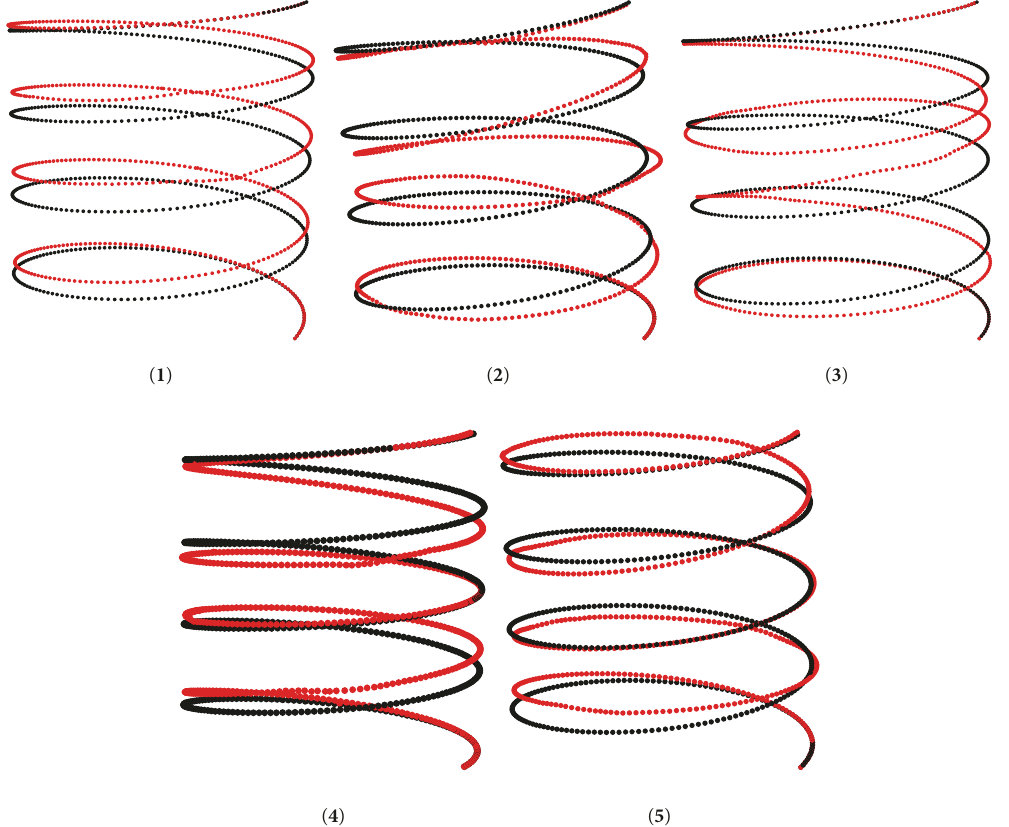
Figure 4: First five mode shapes of Beam 1: ( 1 ) first mode (523.25 Hz); ( 2 ) second mode (897.71 Hz); ( 3 ) third mode (914.36 Hz); ( 4 ) fourth mode (973.88 Hz); ( 5 ) fifth mode